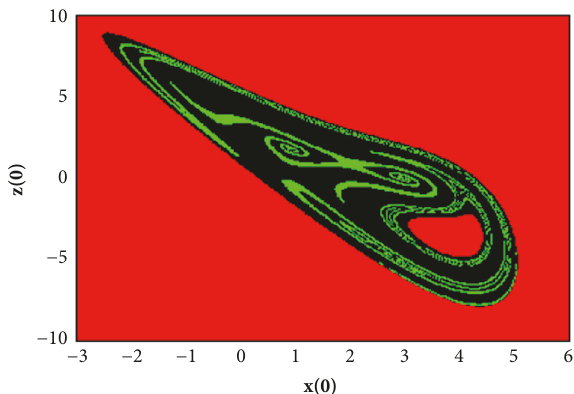
Figure 7: (Color online) Cross section of the basin of attraction of system (1a), (1b), and (1c) in the x-z-plane at 𝑦 = 0 for 𝑎 = 3.3 and 𝑏 = 3.189 . Initial conditions in the black region lead to unbounded orbits, those in the green region lead to the periodic attractor and those in the red region lead to the strange attractor.